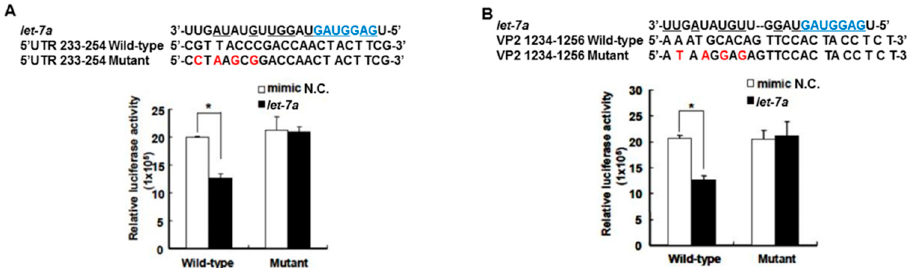
Figure 3. Let-7a specifically targeted 5 (cid:48) UTR and VP2 sequences of EV71. The predicted let-7a targeted EV71 sequences, 5 (cid:48) UTR 233–254 and VP2 1234–1256, and their mutants were cloned into the pMIR™ reporter plasmid. The reporter plasmid was then co-transfected with 200 nM let-7a into the HEK 293T cells. The luciferase activity of the reporter plasmid was evaluated at 24 h post-transfection. The suppressive effect and specificity of let-7a on 5 (cid:48) UTR sequence 233–254 ( A ) and VP2 sequence 1234–1256 ( B ) are shown. The seed sequence of let-7a is depicted in a blue color. The mutated nucleotides on the viral targeted sequences are shown in a red color. The pairing nucleotides between let-7a and the viral sequences are underlined. The negative control of miRNA is a scrambled sequence of let-7a (NC). Mean ± SD, *: p < 0.05.